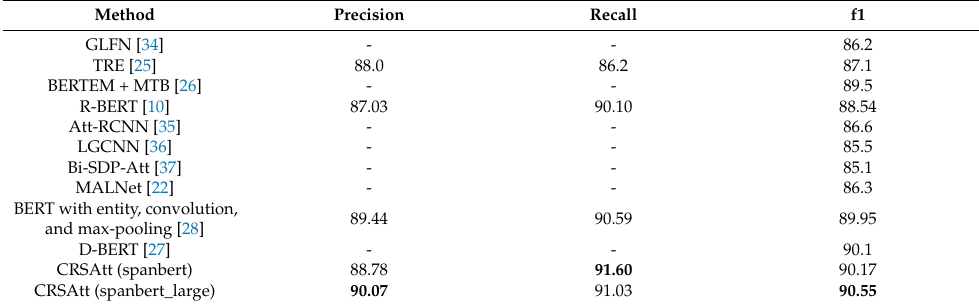
Table 7. Comparison of our model with existing methods on the SemEval-2010 Task 8 dataset.